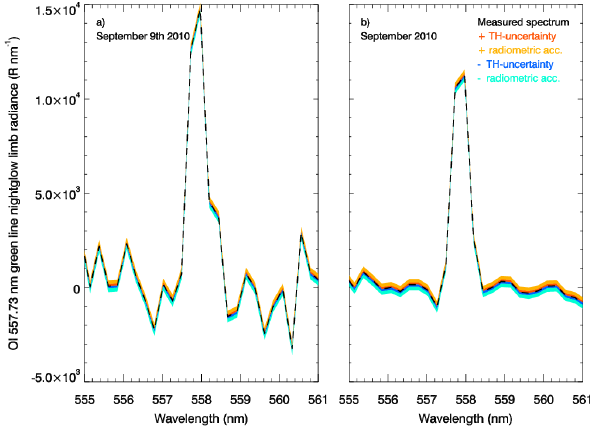
Figure 3. Sample daily (a) and monthly (b) averaged green line emission spectra (calculated by averaging 12 (a) and 480 (b) orbital spectral measurements) at 95km altitude for the 20–25 ◦ N latitude range with uncertainty components σ + (orange), σ + a (yellow), σ − h h (light blue) and σ − a (cyan). See Sects. 3 and 6.1 for further details.